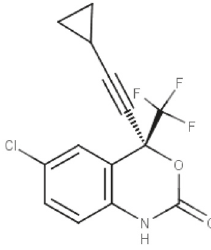
FIGURE 23 - Structure of